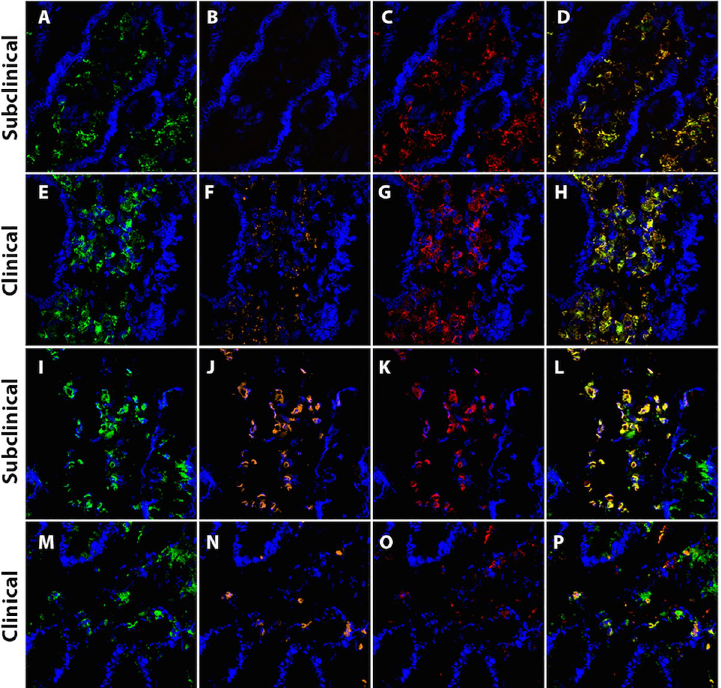
Fig 3. Representative IF labeling in frozen bovine mid-ileal tissue, comparing cows subclinically and clinically infected with Mycobacterium avium subsp. paratuberculosis (MAP). Nuclear staining was performed using 4’,6- diamidino-2-phenylindole, dihydrochloride (DAPI, blue). Each merged image was selected as an example of representative IF labeling from a single cow. (A and E) CD163; (B and F) TLR4; (C and G) AM-3K; (D and H) merged image of CD163, TLR4 and AM-3K; (I and M) CD206; (J and N) uNOS; (K and O) AM-3K; (L and P) merged image of CD206, uNOS and AM-3K.